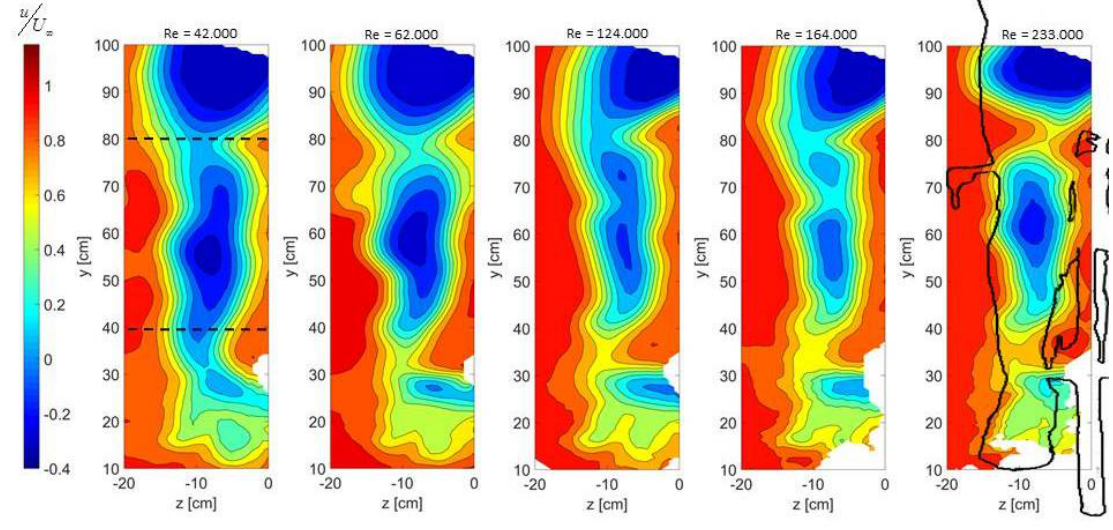
Figure 3. Spatial distribution of non-dimensional time-average streamwise velocity at increasing freestream velocity. The contour of the mannequin is included at Re = 233.000 only for better